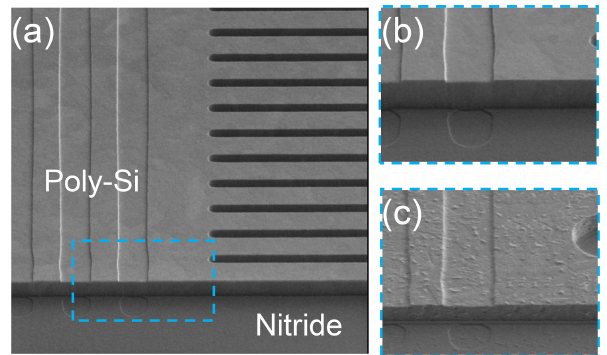
Figure 5. Influence of subsequent dry-etching processes on the sur- face roughness of the polysilicon (Poly-Si). (a) SEM image taken after waveguide and grating etch. Panels (b) and (c) represent a magnified view of the marked area (blue dashed rectangle) before and after treatment with a silicon dry-etching sequence following the wet-chemical metal etch of AlSiCu, respectively. All SEM im- ages are taken with a tilt of 30 ◦ .